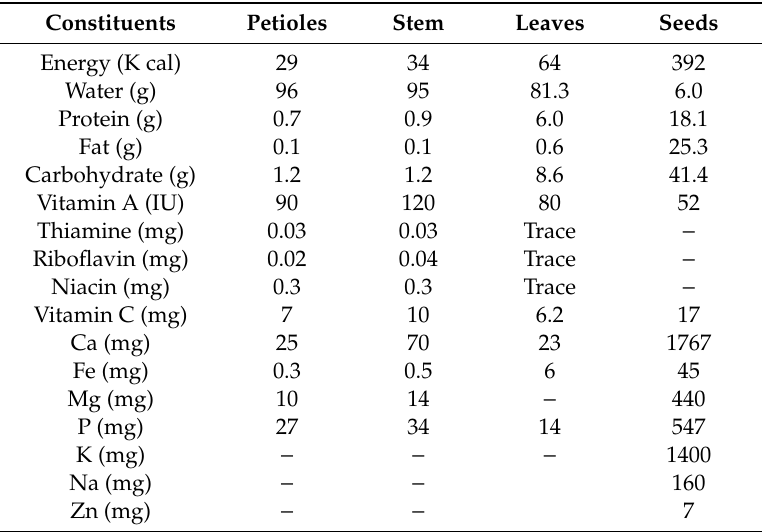
Table 2. Proximate nutrient composition of Apium graveolens (per 100 g)